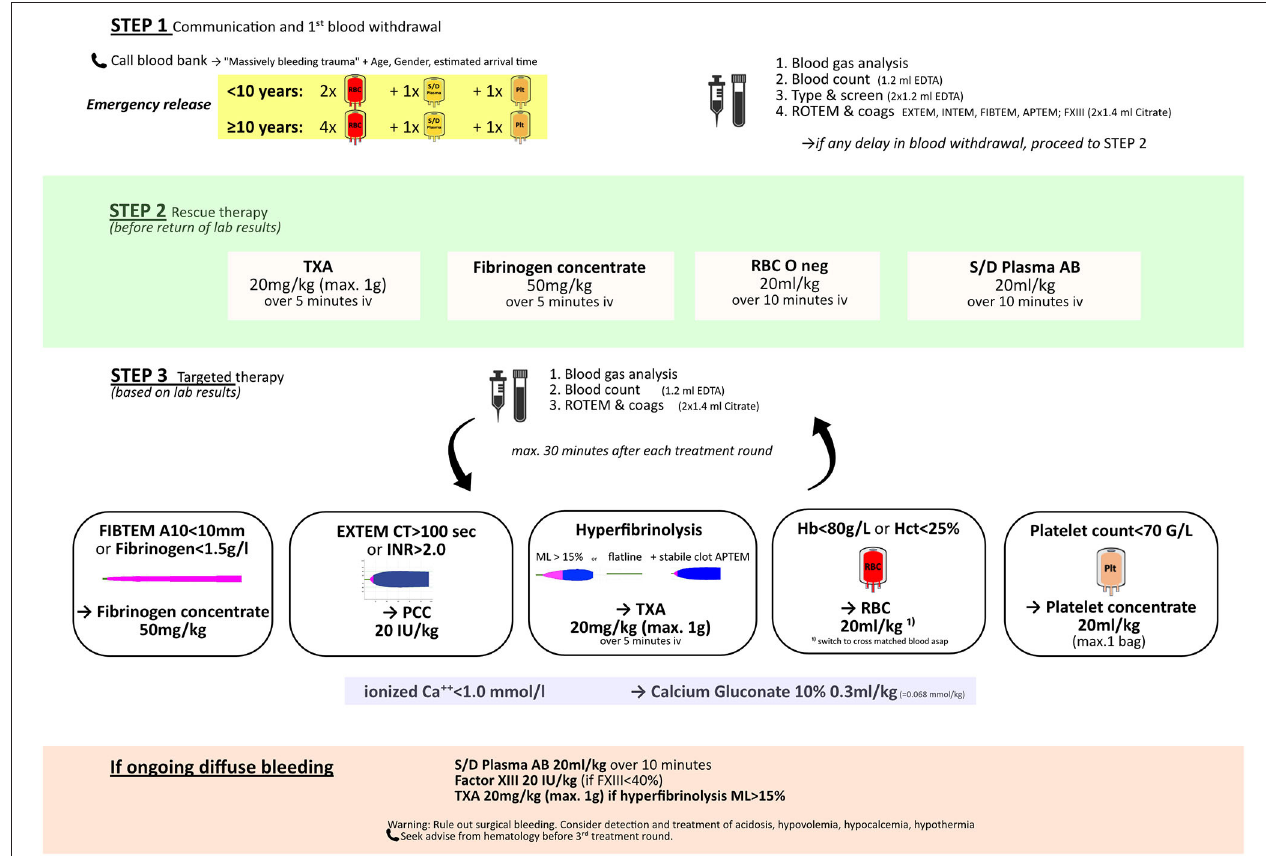
FIGURE 2 | Example of a goal-directed pediatric bleeding management algorithm. TXA, tranexamic acid; RBC, red blood cells; S/D plasma AB, solvent/detergent pooled plasma, blood group